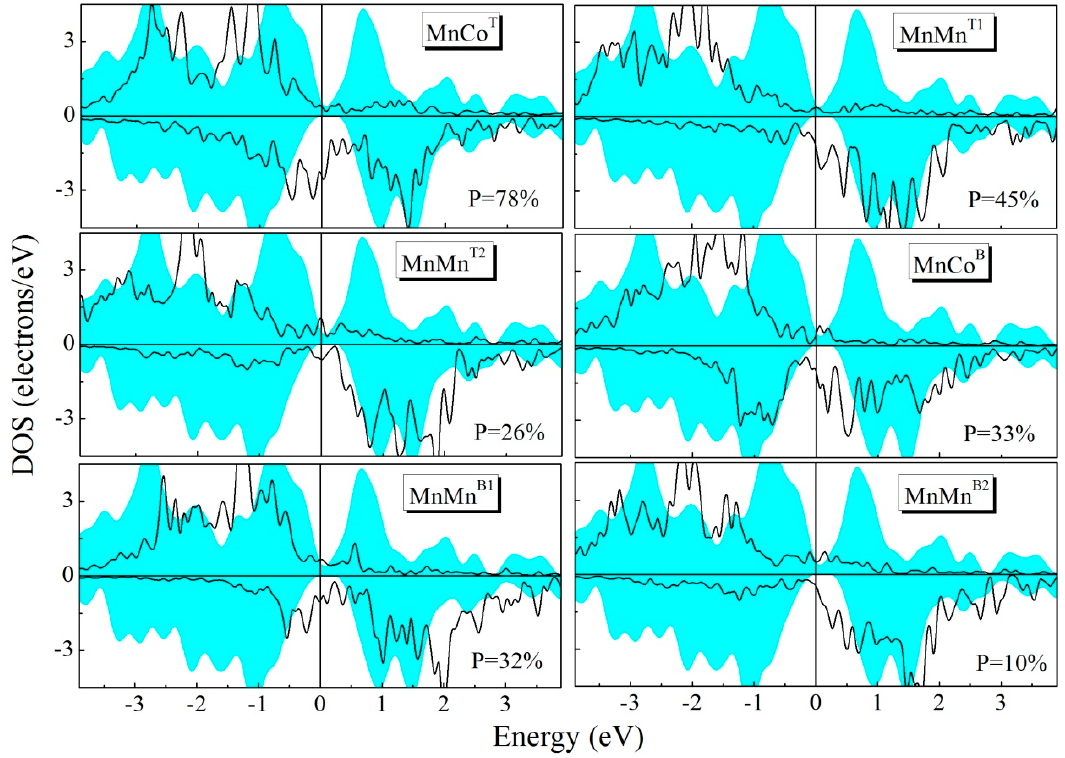
Figure 6. The total density of states (DOS) of various structures. The shadow region indicates the DOS of the Mn 2 CoAl bulk. P stands for spin polarization.